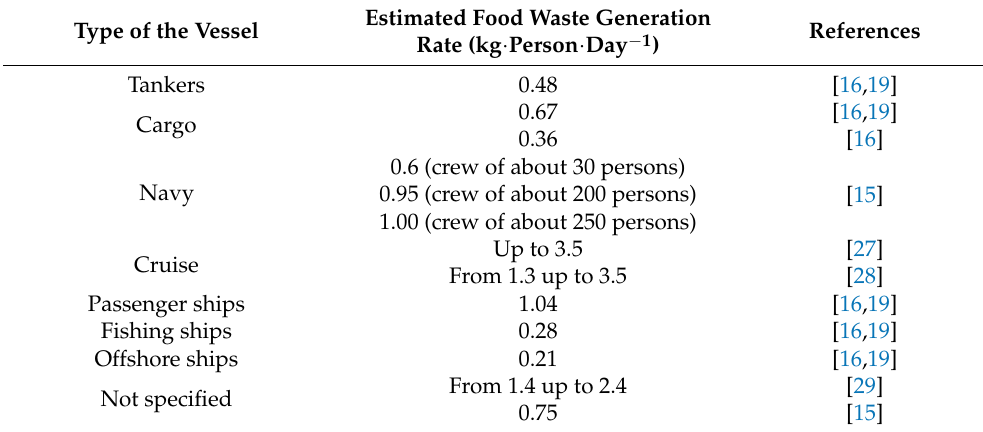
Table 4. Estimation of average amount of food waste generated by one person every day on different vessels according to literature